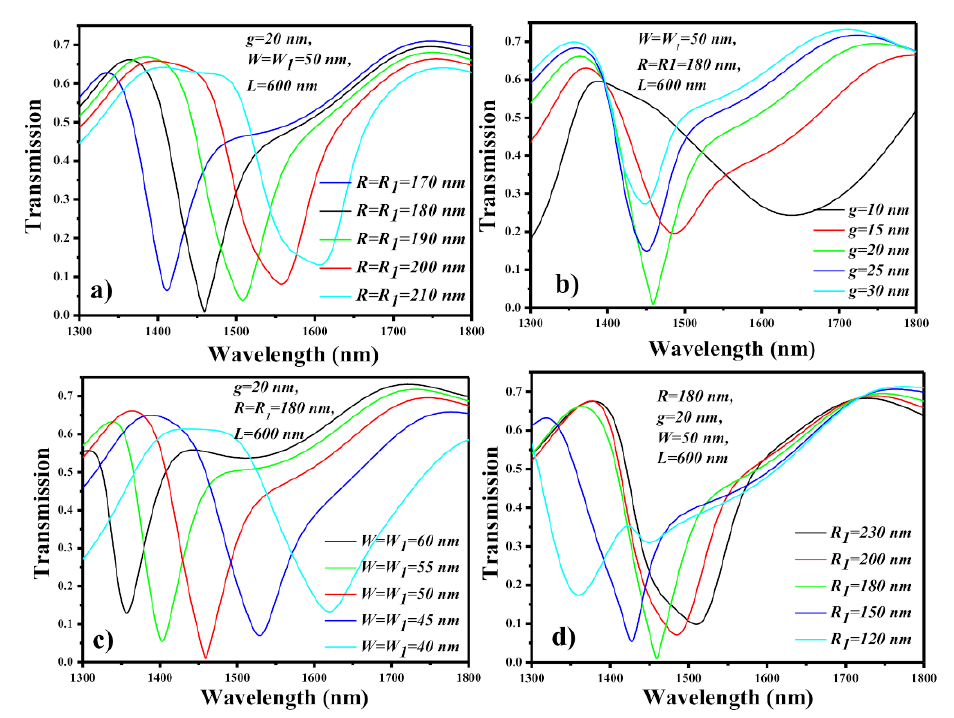
Figure 6. Optimization of racetrack integrated circular cavity: ( a ) R, R 1 variation (where R = R 1 ), ( b ) g variation, ( c ) W , W 1 variation (where W = W 1 ), ( d ) R 1